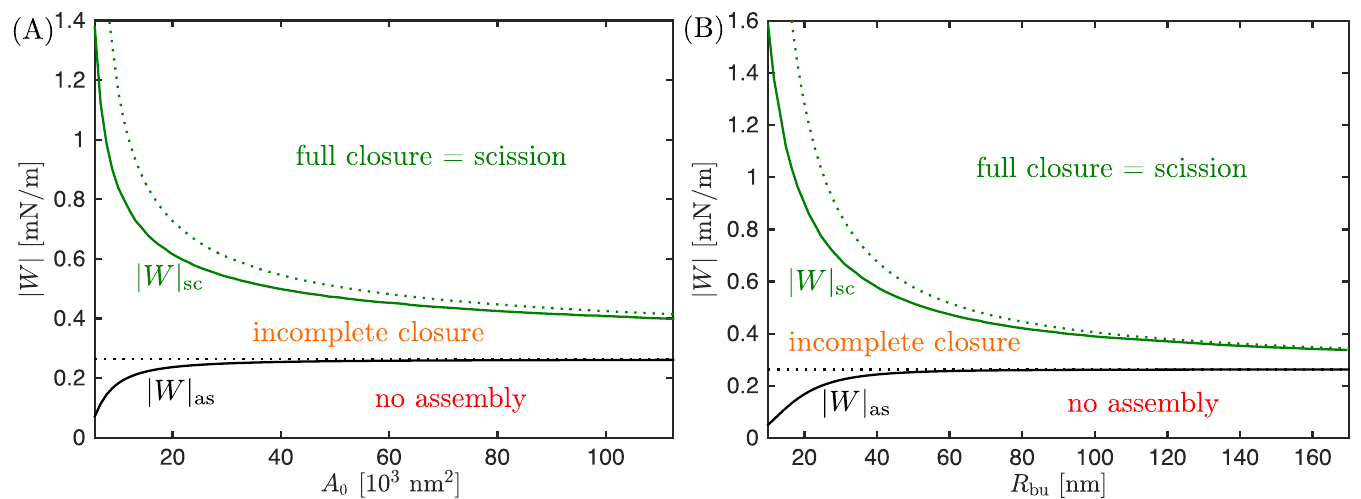
Fig 4. Dome-shaped assemblies as a function of bud size and adhesive strength | W |. The radius of the membrane neck will become sufficiently small ( R ne = 3 nm) and thus full neck closure and scission will occur only if the membrane–protein adhesion strength | W | is sufficiently large with | W | > | W | sc ; the closure of the neck will be incomplete for intermediate values of | W | with | W | sc > | W | > | W | as ; and the dome will not assemble at all if the adhesive strength | W | is too small with | W | < | W | as . The critical values of the adhesive strength | W | as corresponding to θ = 0˚ and | W | sc corresponding to θ = 75˚ are plotted (A) as a function of the total bud area þ 2 p R 2 ; and (B) equivalently as a function of the final bud radius R bu . The solid lines correspond to numerical results, whereas the dotted lines correspond A 0 ¼ 4 p R 2 bu do to the analytical approximations given by Eqs 7 and 9.